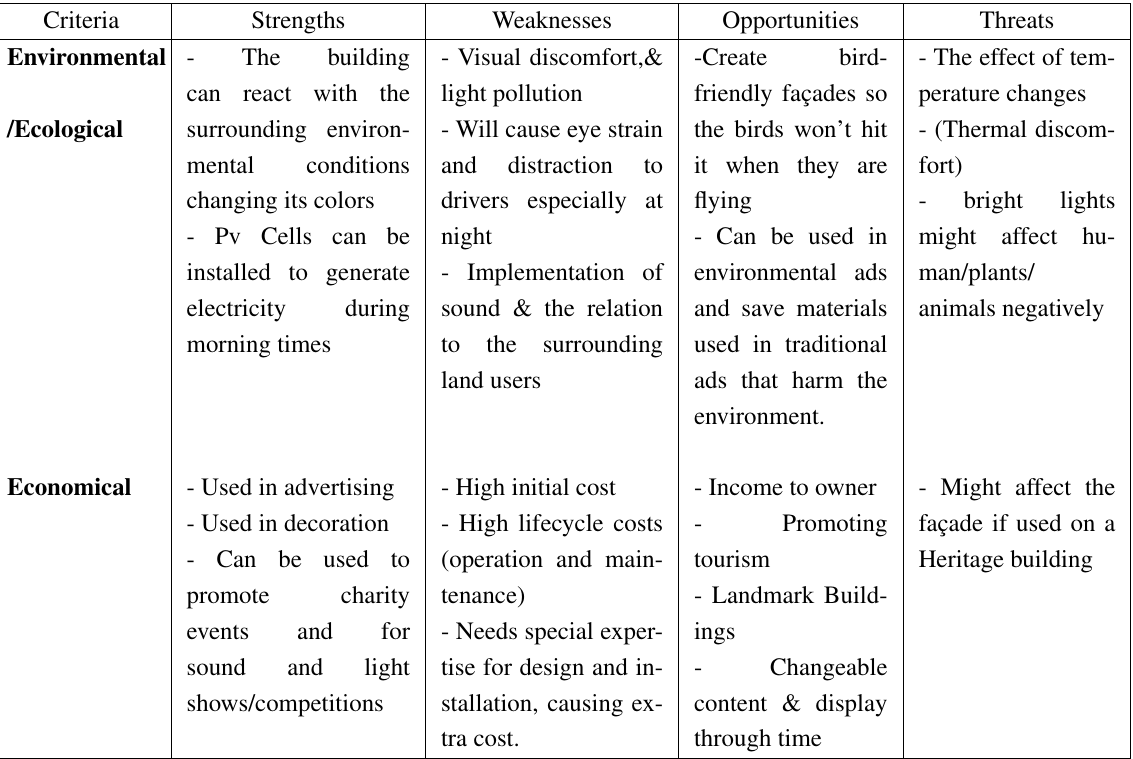
Table 2. SWOT Analysis for the case